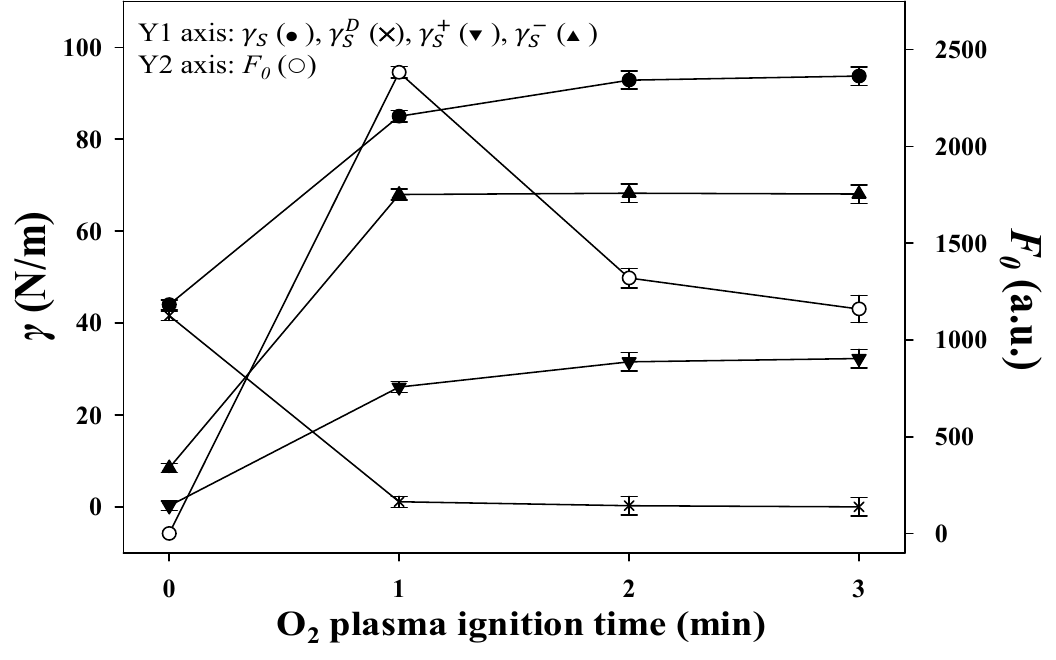
Figure 3 . The dependence of O 2 plasma duration on the total ( 𝛾 (cid:3020) , ● ), dispersive ( 𝛾 (cid:3020)(cid:3005) , × ), acid ( 𝛾 (cid:3020)(cid:2878) , ▼ ), and base ( 𝛾 (cid:3020)(cid:2879) , ▲ ) surface free energies of PI substrates and on the fluorescence intensity, F 0 ( ○ ), of the